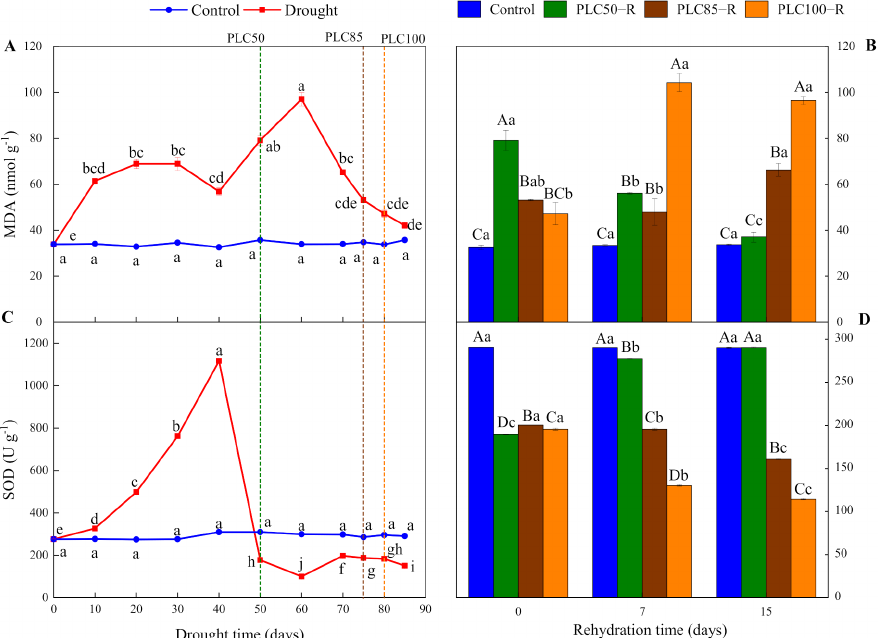
Figure 4. Dynamics of MDA content and SOD activity in Pinus massoniana seedlings after drought and subsequent rehydration. Panels ( A , C ) represent the dynamics of MDA and SOD under drought treatment, and panels ( B , D ) represent the dynamics of MDA and SOD after subsequent rehydration. Different lowercase letters indicate significant differences between sampling dates within the same treatment ( p < 0.05), while different capital letters indicate significant differences between treatments on the same sampling date ( p < 0.05). Dashed lines represent the time when PLC reached 50% (PLC50, green), 85% (PLC85, brown), or 100% (PLC100, orange), while rehydration (PLC50 − R, PLC85 − R, and PLC100 − R) followed immediately. Values represent means ± SD ( n =